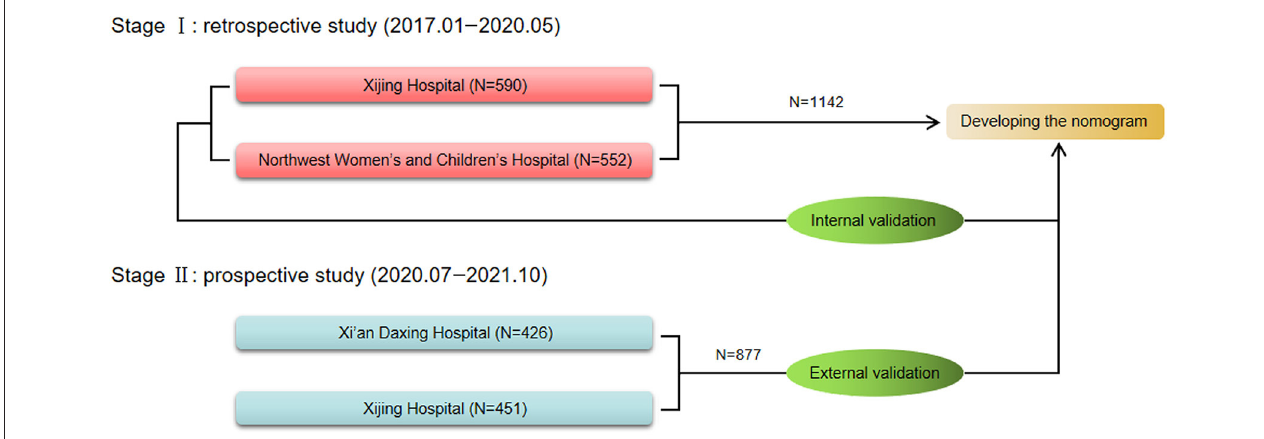
FIGURE 1 | The flow chart of this